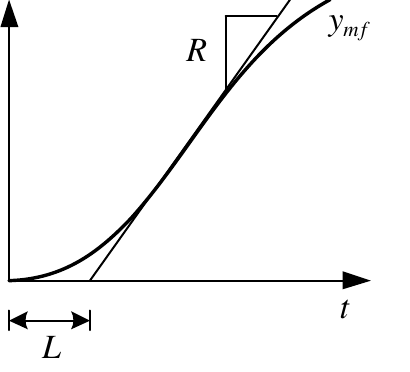
Figure 8: Ziegler-Nichols’ open loop method: The equivalent dead-time L and rate R read off from the process step response.